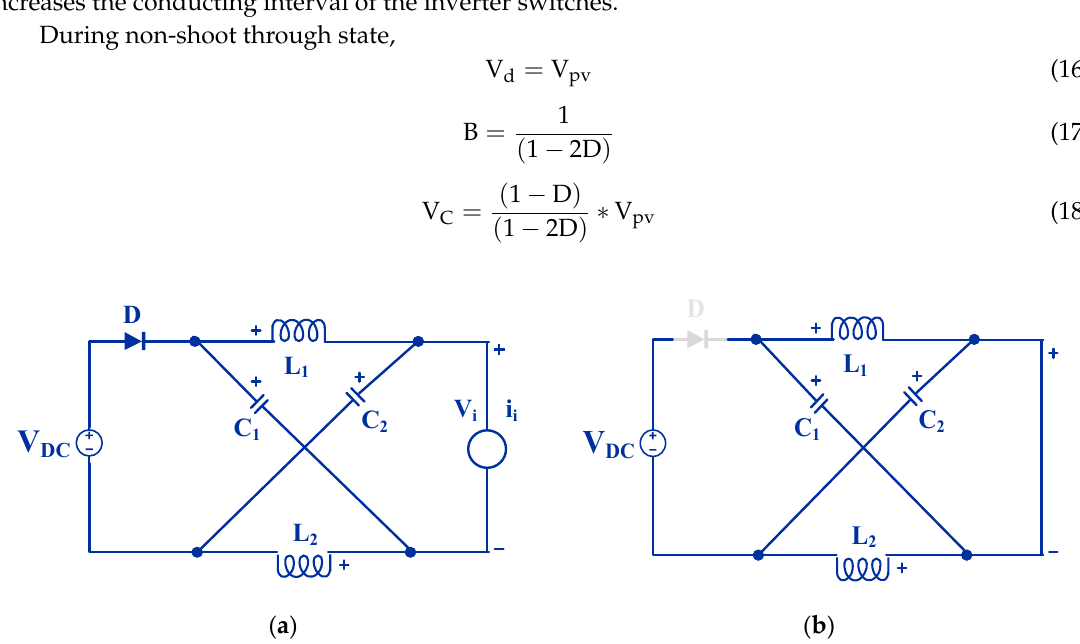
Figure 11. Circuit diagram of ZSI.